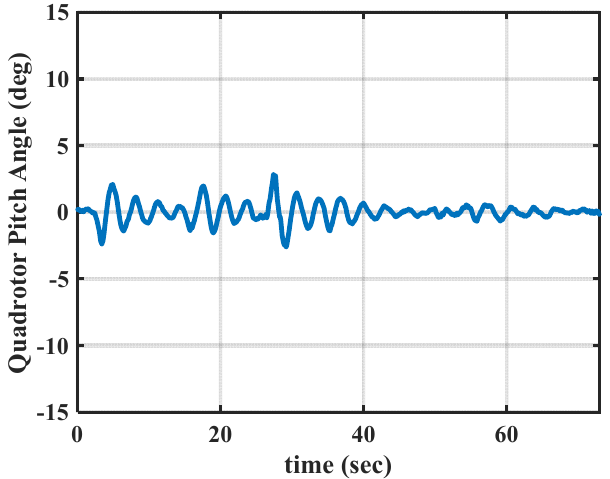
Figure 15. Quadcopter roll angle.